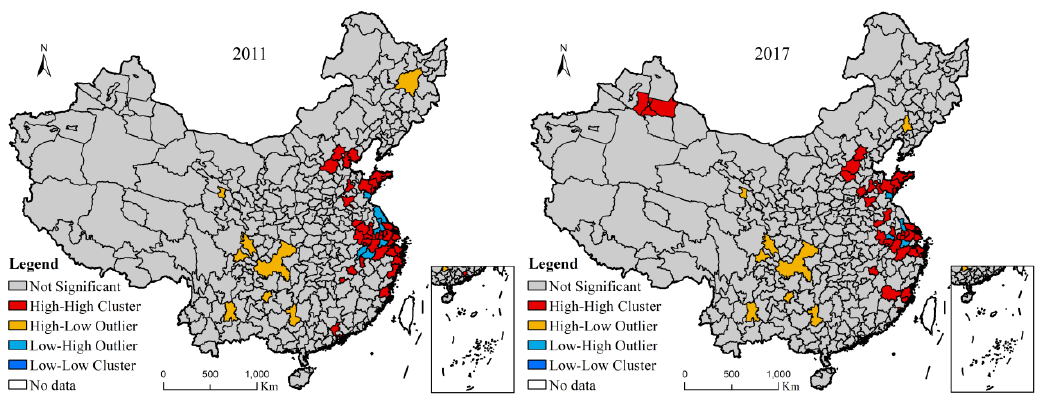
Figure 2. Local indicators of spatial association (LISA) pattern of green technology efficiency in China’s manufacturing industry. Energies 2020 , 13 , x FOR PEER REVIEW